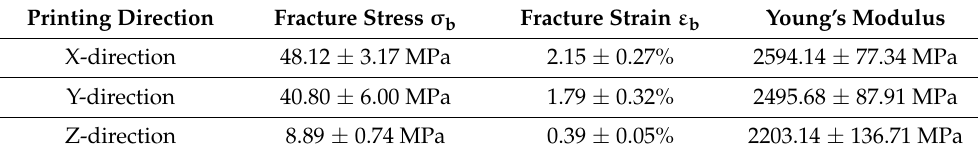
Table 3. Average result with standard deviation of tensile test of 3D printed samples.